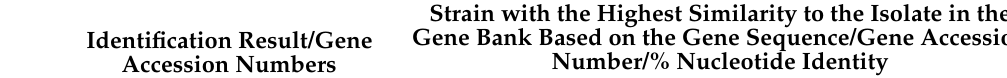
Table 3. Molecular identification of bacterial strains with antimicrobial activity isolated from the midgut of A. solstitiale